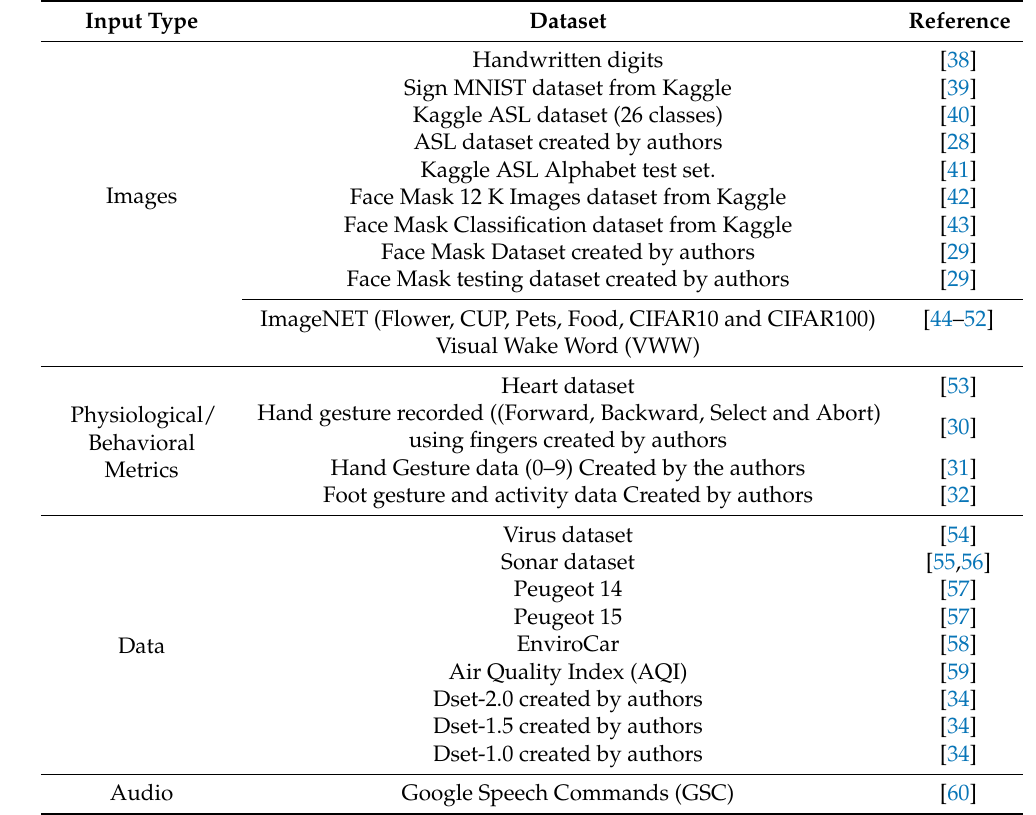
Table 4. Summary of datasets used in TinyML studies including input type.